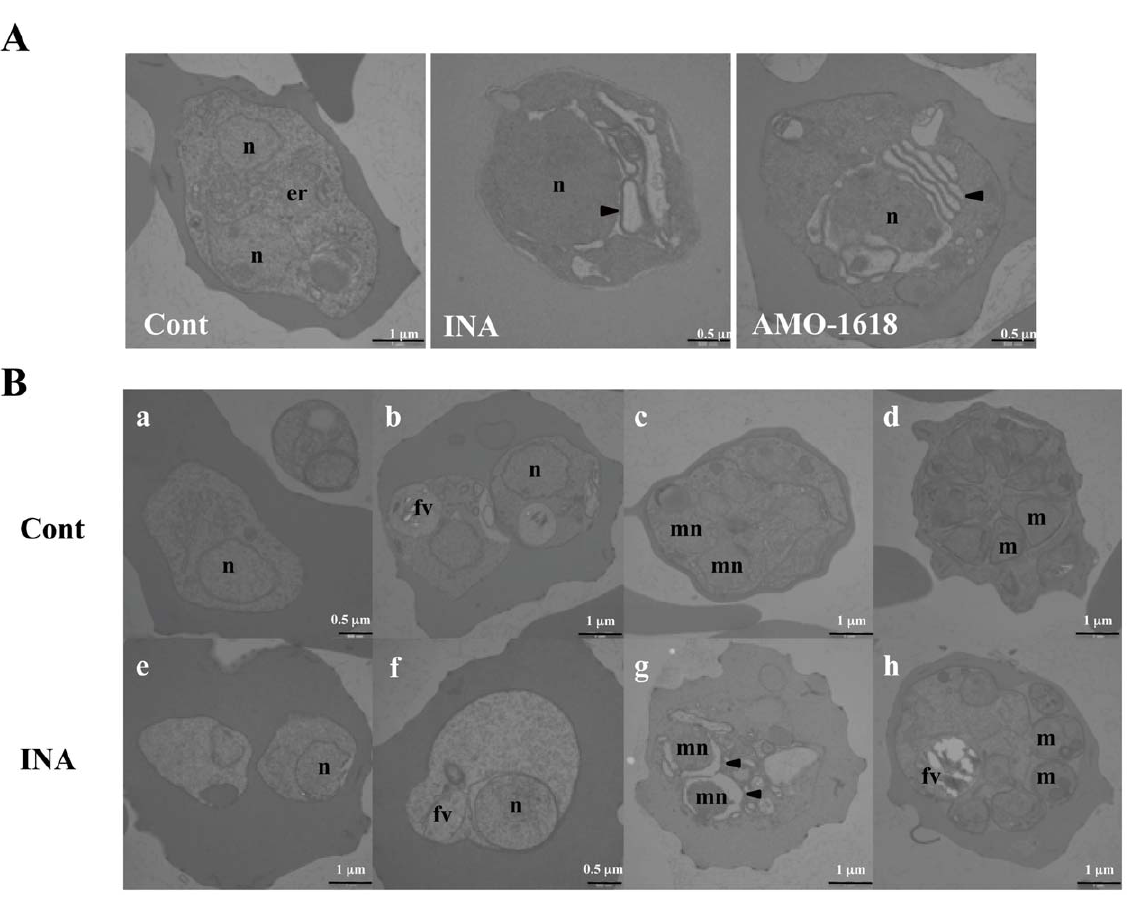
Figure 4. Transmission electron microscopy of parasitized erythrocytes treated with inhibitors. (A) Sections through an erythrocyte containing a trophozoite-stage parasite exposed to 0.1% DMSO for 6 h, 50 m M INA for 6 h or 250 m M AMO-1618 for 8 h, respectively. (B) Asynchronized parasites were treated with 0.1% DMSO (a–d) or 50 m M INA for 6 h (e–h). Sections from representative stages during intraerythrocytic development: ring- (a and e), early trophozoite- (b and f), mature trophozoite- (c and g) and schizont-stage parasites (d and h) are shown. Nuclei (n), food vacuoles (fv), merozoites (m), nuclei of merozoites (mn) and abnormal gaps between the nuclei and the nuclear envelopes (arrowheads) are indicated. Scale bar is indicated at the bottom of the images.